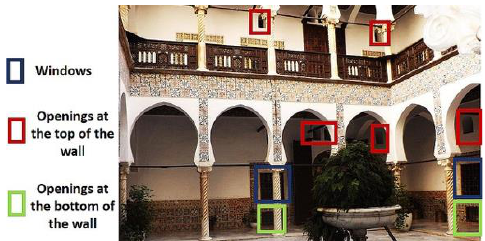
Figure 11. The patio in the house of the Kasbah of Algiers